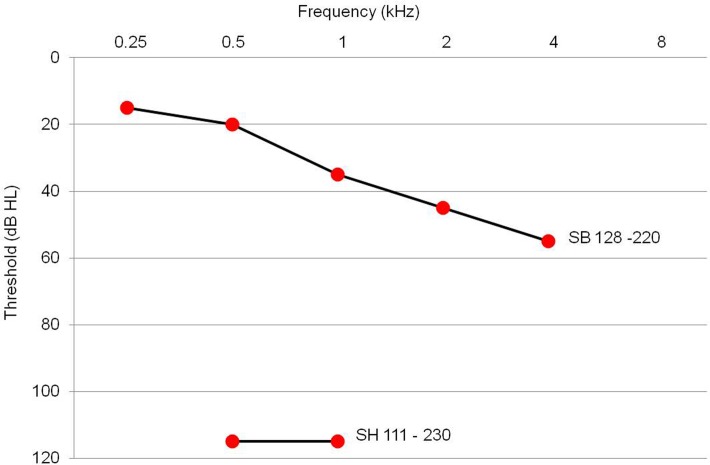
Overlapping audiograms from two subjects who were c.235delC homozygotes.The subjects showed dramatically different levels of hearing loss, with one subject showing moderate hearing loss (mean hearing threshold, 38.8 dB) and the other showing profound hearing loss (mean hearing threshold, 110 dB).